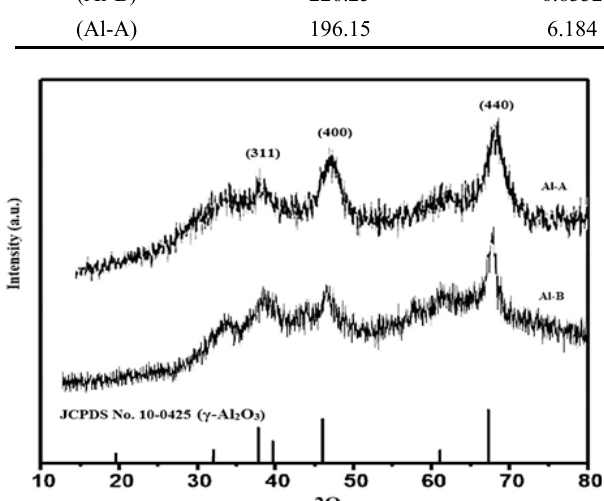
Fig. 6 . XRD pattern of the as prepared hollow and porous γ-alumi - na nanosphere compared with standard γ-alumina